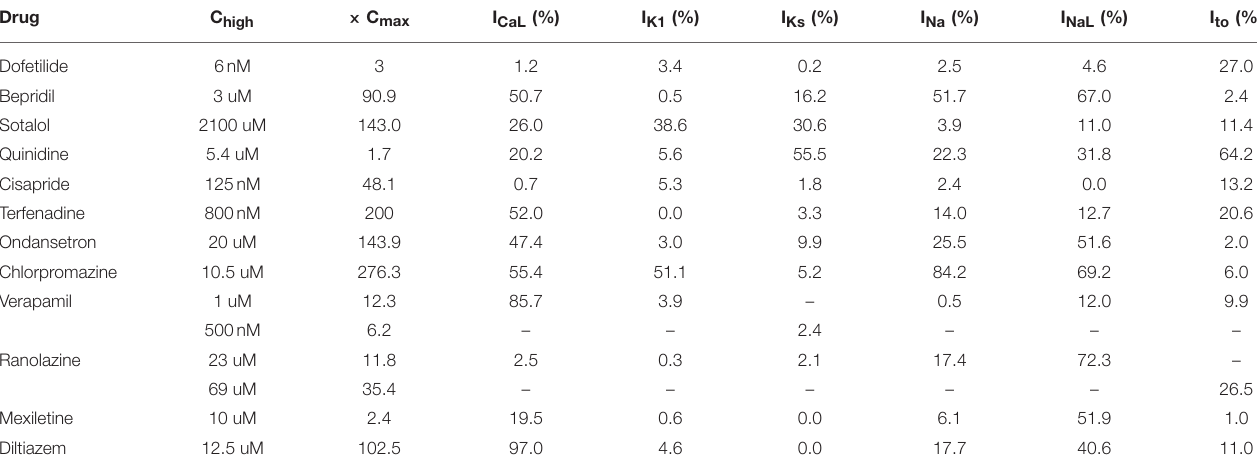
TABLE 4 | Mean current block at the highest drug concentrations tested in experiments (C high ). Drug C high